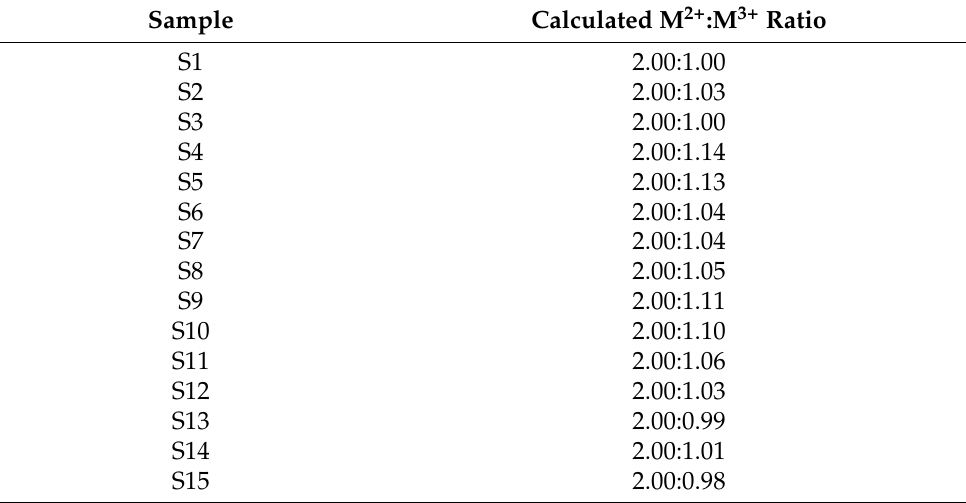
Table 2. M 2+ :M 3+ ratios for each sample as calculated from XRF data obtained.